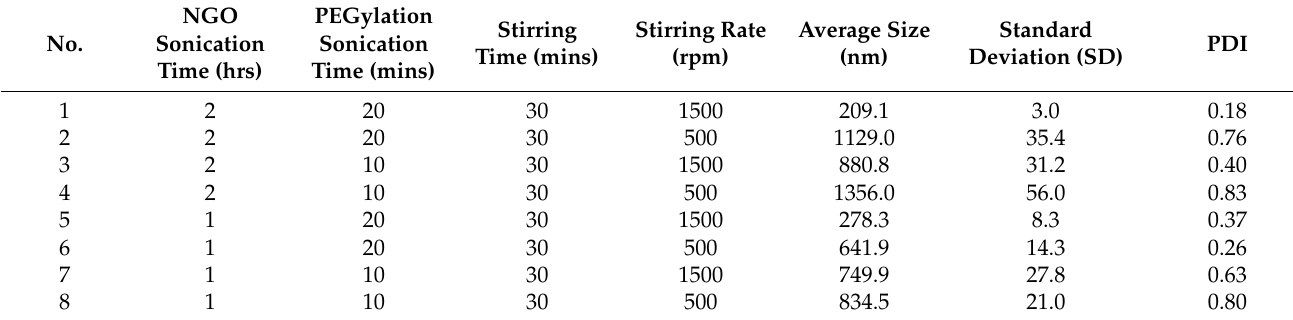
Table 1. Average particle size of acetaminophen-loaded NGO-PEG suspensions prepared using DoE. NGO Soni- No.